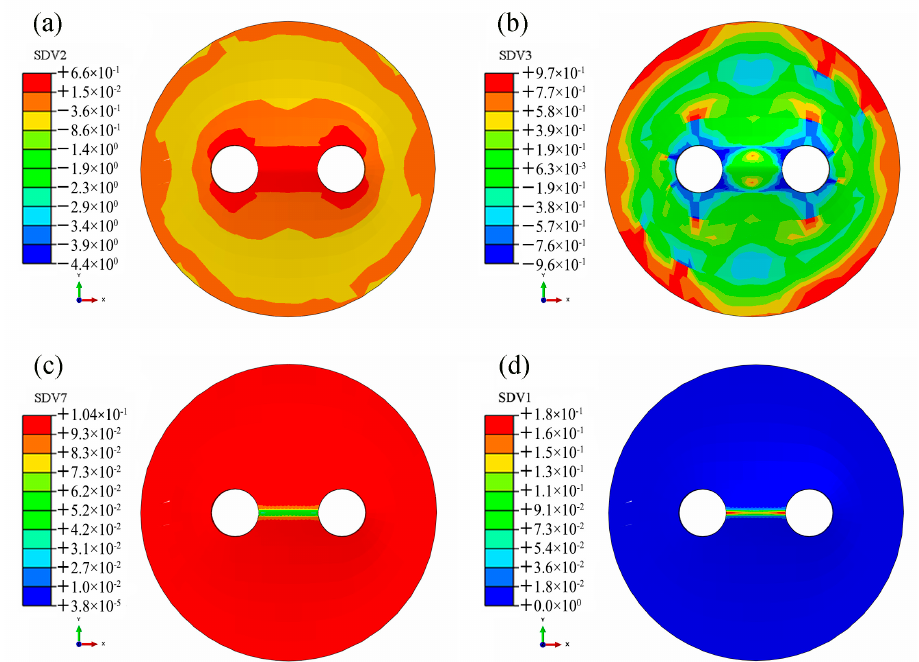
Figure 14. The FE simulated results of the two-hole specimen model after the second cyclic loading: ( a ) stress triaxiality; ( b ) Lode angle parameter; ( c ) retained austenite; ( d ) EPS.